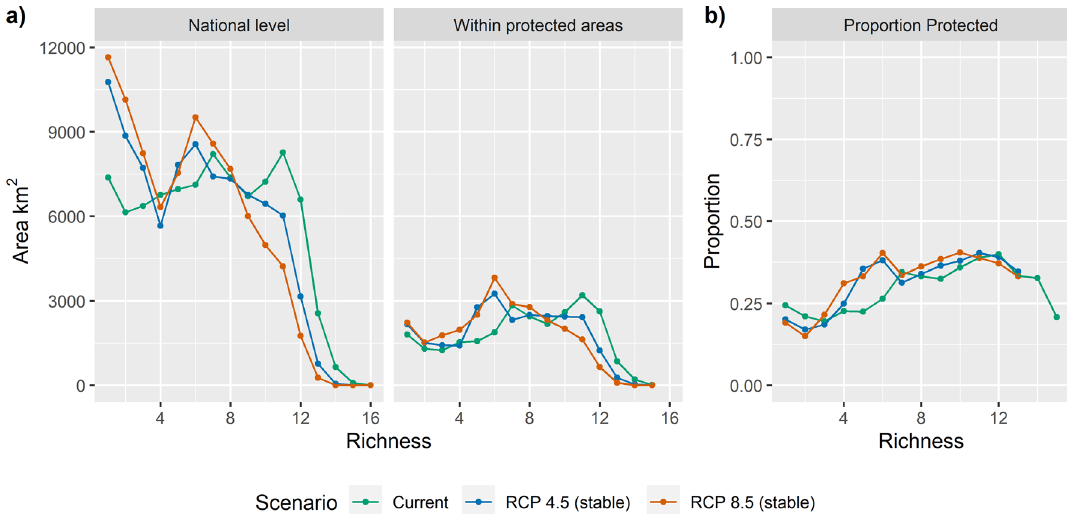
Figure 4. ( a ) The total area by species richness for the current and two future climate scenarios (RCP 4.5 and RCP 8.5 for 2070)—only stable areas were calculated for future climate scenarios—at the national level and within protected areas only for dipterocarp species in the Philippines. ( b ) The proportion of the area by species richness at the national level that exists within protected areas. Proportion data was excluded if the area was less than 50 km 2 (seen as absent points), as it may lead to arbitrarily high proportion protected values. The figure was created in R using the ggplot2 package 66,121 .